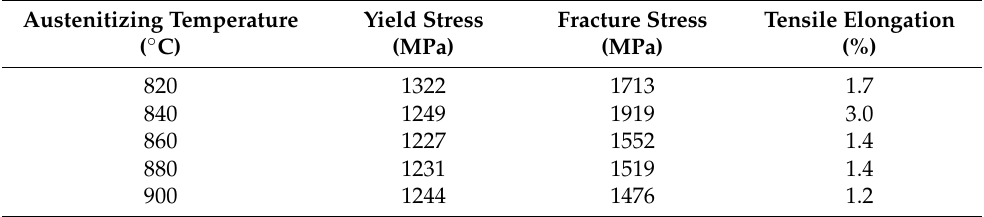
Table 3. The tensile properties of the carburized specimens of the experimental